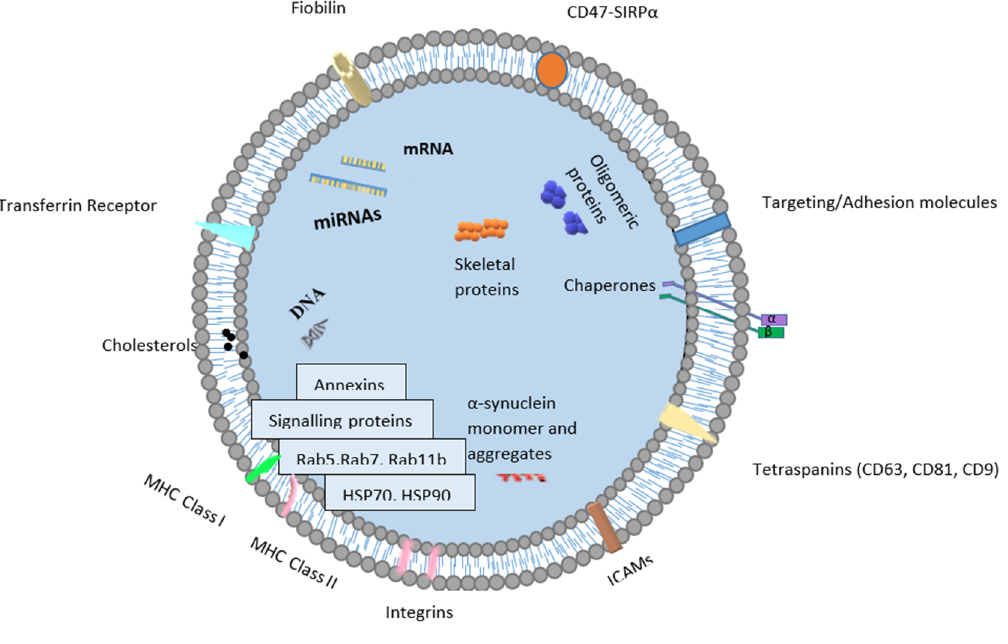
Figure 1. Schematic diagram of an exosome.